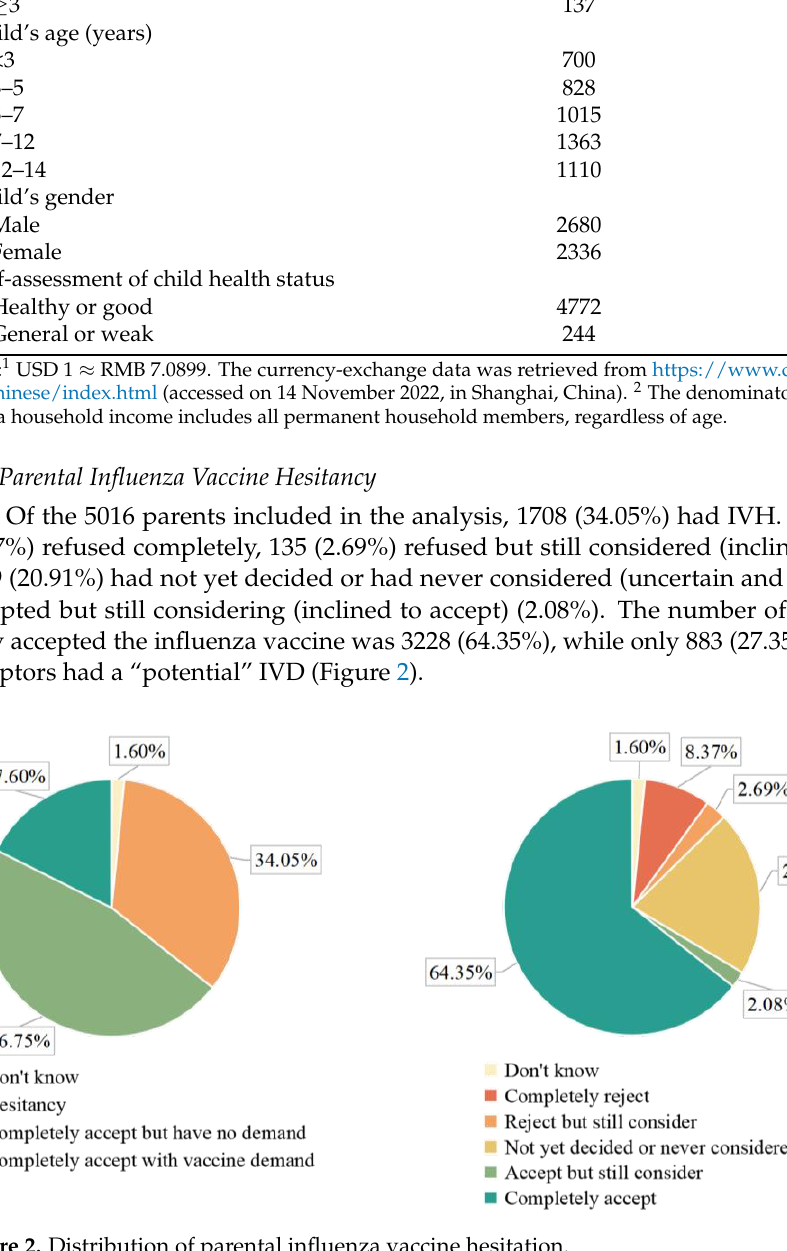
Figure 2. Distribution of parental influenza vaccine hesitation.